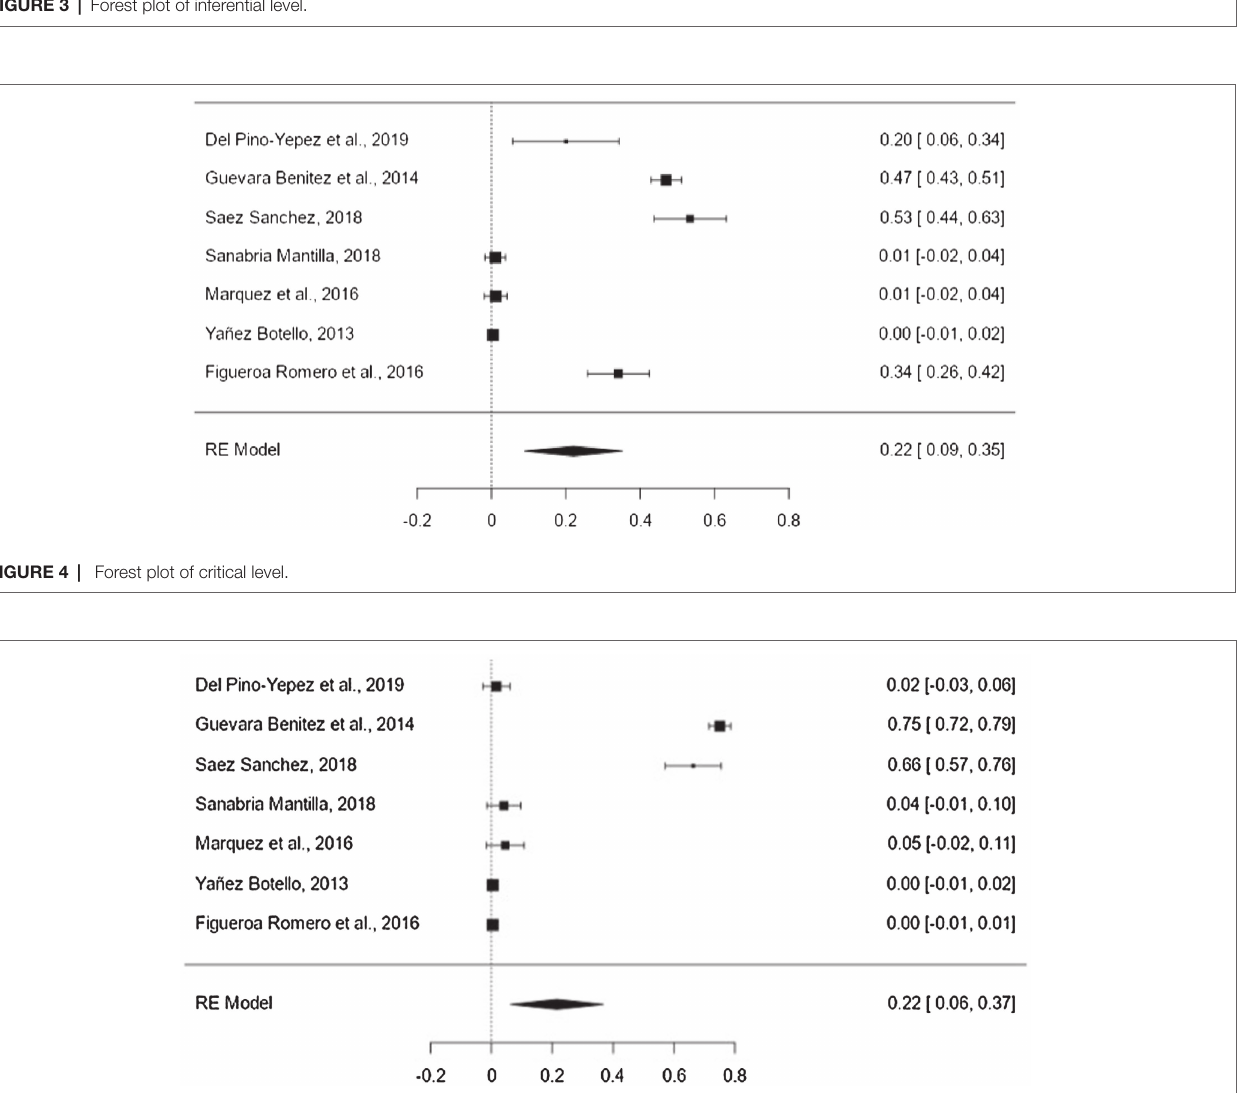
FIGURE 3 | Forest plot of inferential level.